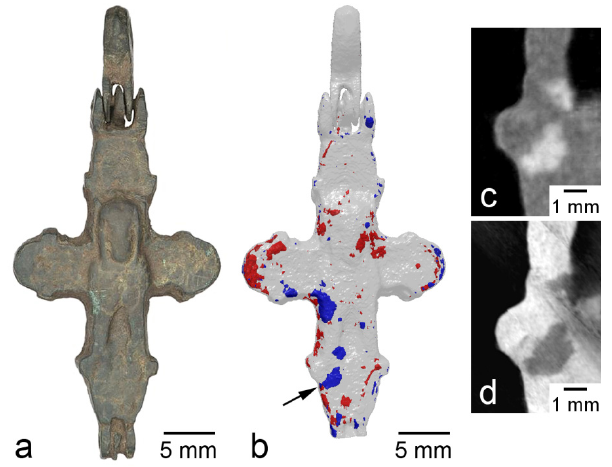
Figure 2. Images of the cross from Soroguzhino-2: ( a ) photograph; ( b ) 3D rendering of the corroded regions, shown in different colors for the different valves; tomography slices of a corrosion region identified in ( b ) by an arrow, taken with neutron ( c ) and synchrotron ( d ) radiation.